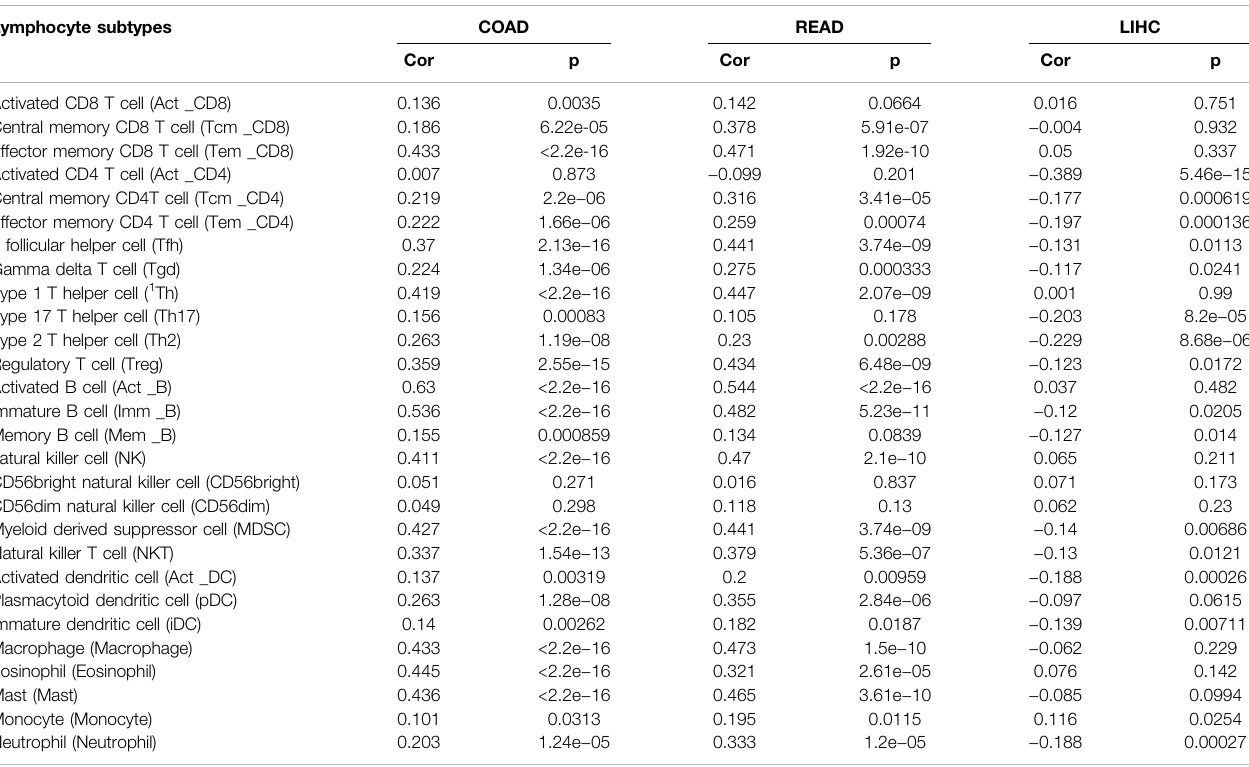
TABLE 1 | The correlation between GNG7 expression and tumor lymphocyte in fi ltration in COAD, READ and LIHC(TISIDB). Lymphocyte subtypes